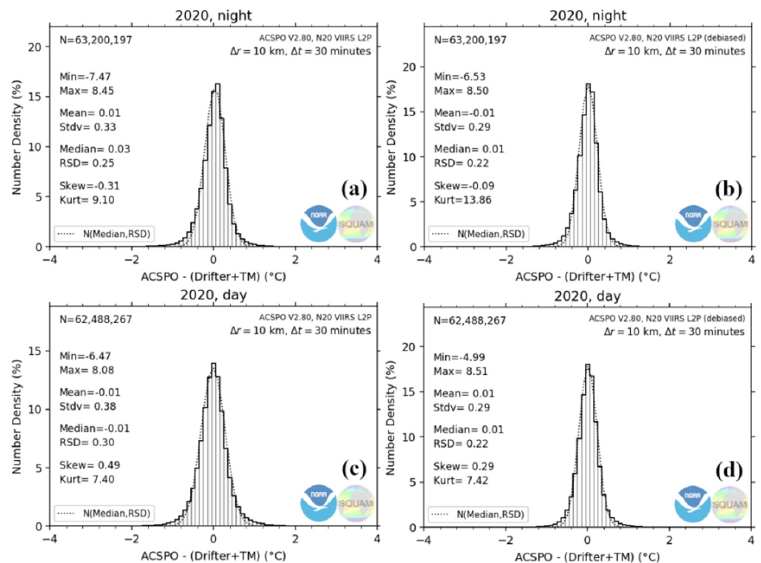
Figure 6. Aggregated for year 2020 histograms of ACSPO - (D+TM) SST for N20: ( a , b ) night; ( c , d ) day; ( a , c ) ‘subskin’ SST (computed using global regression, GR); ( b , d ) ‘depth’ SST (computed using piecewise regression, PWR). Figures are from the NOAA SQUAM system [18].